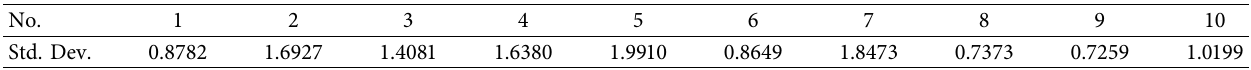
Table 3: The standard deviation of NS of sectors in three